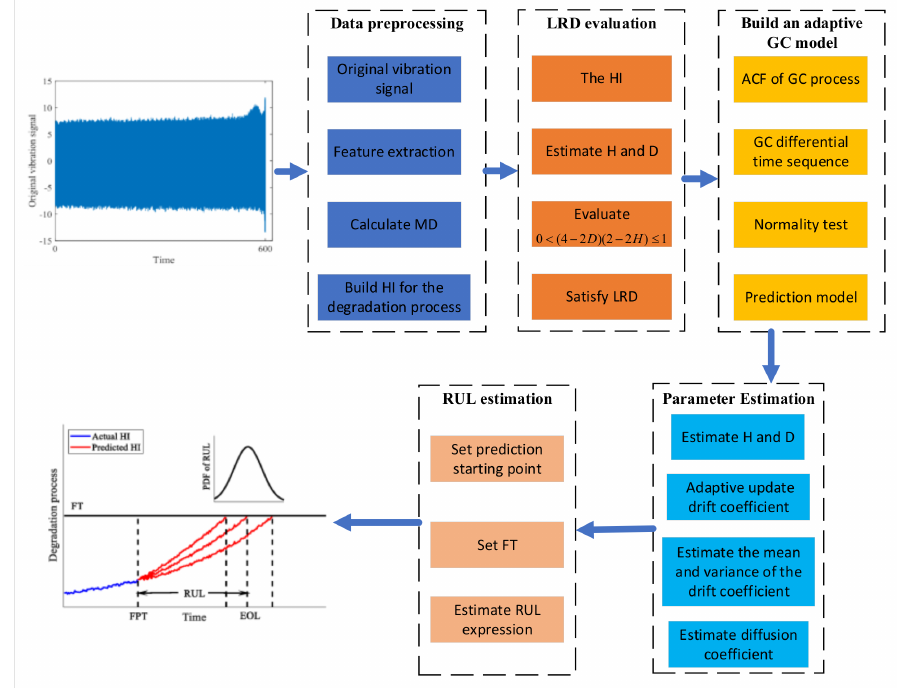
Figure 7. Flowchart of the procedure for RUL prediction.